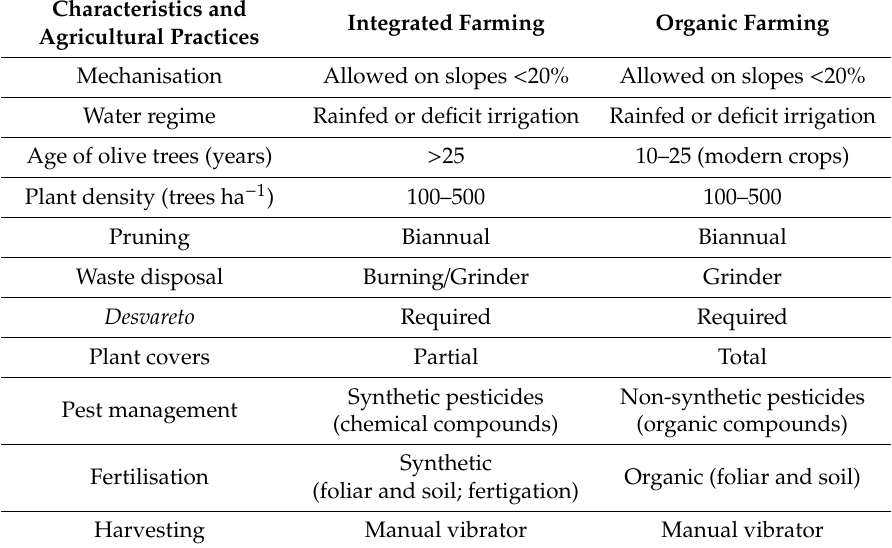
Table 1. Main characteristics and agricultural practices carried out in the integrated and organic farming of the olive grove [14]. Desvareto is an agricultural practice related to the removal of stems from the olive